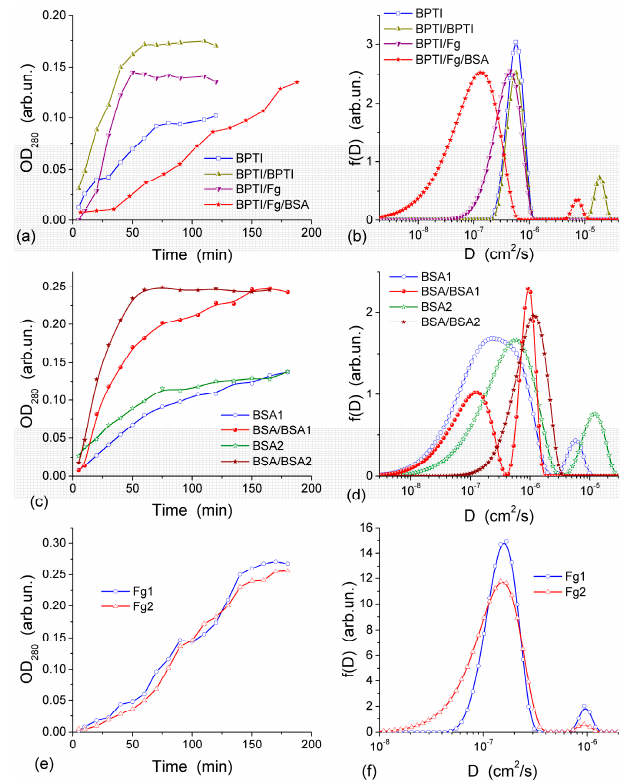
Figure 13. Diffusion kinetics through a collagen HG membrane (~1 mm in thickness) for ( a ) BPTI. Curve 1 is for an initial concentration of 1.23 mg/mL in the feeder cell (OD 280 = 0.09), curves 2–4 are for an initial concentration of 2.46 mg/mL (OD 280 = 0.18); curve 2—BPTI run after the first BPTI run; curve 3—BPTI run after Fg; curve 4—BPTI run after Fg and BSA; ( c ) BSA and BSA (with twice concentration) after the first BSA run, ( e ) Fg (initial concentration 1.7 mg/mL); curves ( b , d , f ) show the corresponding distribution functions of the diffusion coefficient f ( D ) for ( b ) BPTI, ( d ) BSA, and ( f ) Fg (reproduced from Ref. [44] with permission from The Royal Society of Chemistry).